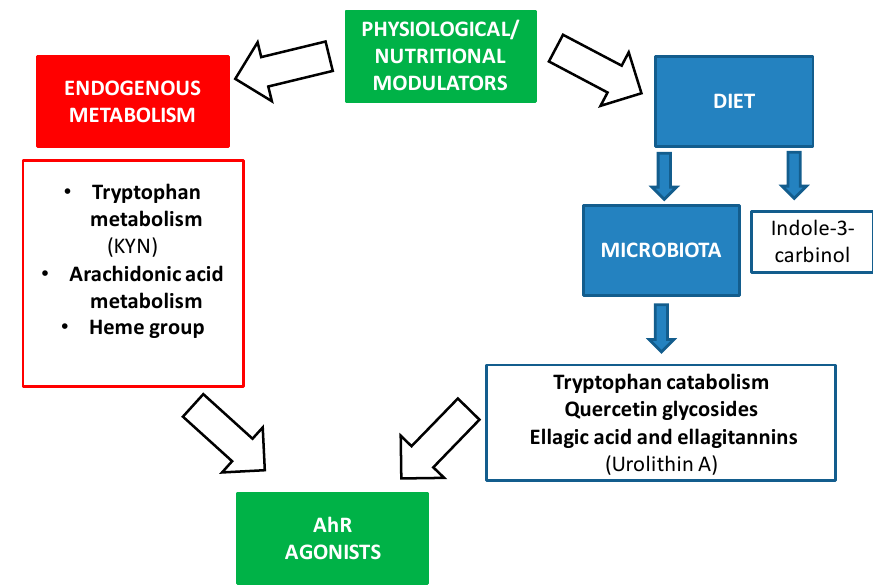
Figure 2. Physiological and nutritional modulators of AhR.